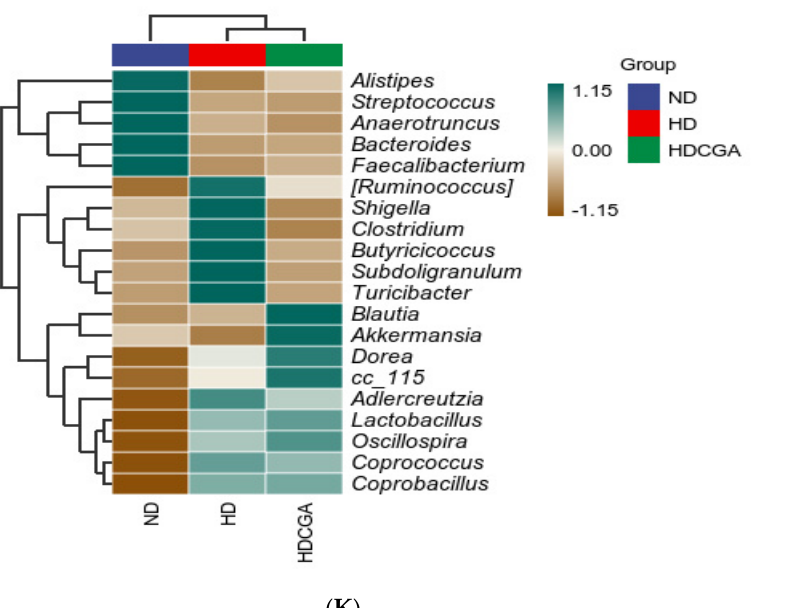
Figure 5. Effect of CGA supplementation on composition and diversity of cecal microbiota of chickens from the ND, HD, and HD + CGA datasets. ( A – C ) CGA was found to increase cecal microbial alpha diversity as measured by Shannon, Simpson, and Chao1 indicators. ( D ) Venn diagram showing unique and shared numbers of genera predicted. ( E ) Two-dimensional OTU abundance based principal coordinate analysis (PCoA) of cecal microbiota. ( F ) Microbial composition at the phylum level. ( G ) Microbial composition at the genus level. ( H ) Abundance comparison of major species at the genera level, from left to right were Faecalibacterium and Alistipes. ( I , J ) Leaf and bar plots obtained by linear discriminant analysis effect size (LEfSe) analysis showed differences in the abundance of broiler fecal microbes. ( K ) The clustering heatmap of the top 20 genera in each sample. Green represents positive correlation and yellow indicates negative correlation. “*” presents a significantly different compared to HD group ( p < 0.05).